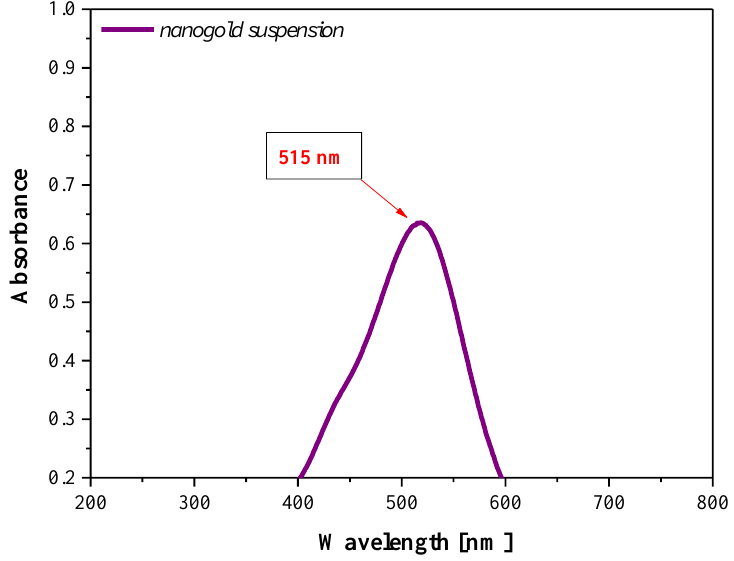
Figure 4. UV-Vis spectrum of nanogold suspension obtained using 3% Arabic gum as a stabilizing – reducing agent.